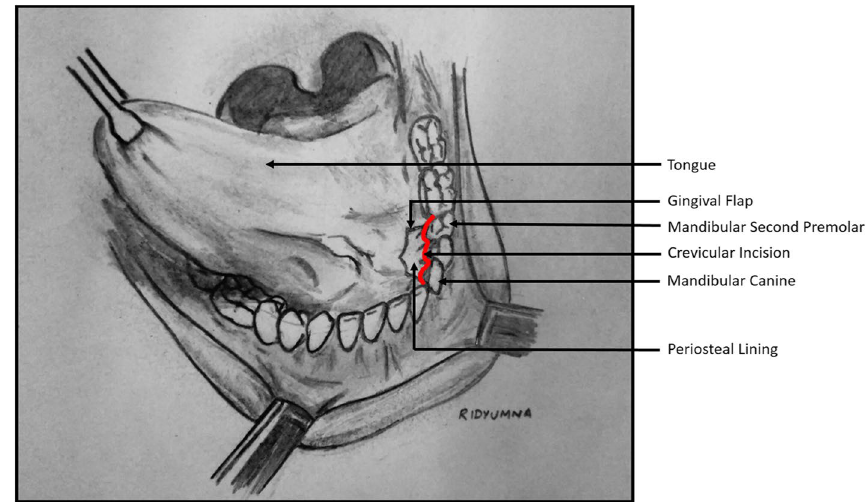
Fig. 4 Sketch demonstrating intra-oral transcrevicular incision placed in the region of canine-premolar without violating the floor of the mouth